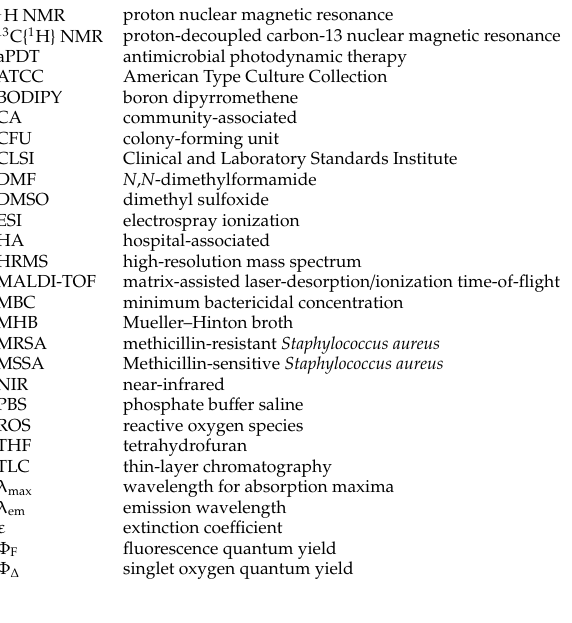
Figure S1: (a) 1 H and (b) 13 C{ 1 H} NMR spectra of 1 in DMSO- d 6 , Figure S2: (a) 1 H and (b) 13 C{ 1 H} NMR spectra of 2 in DMSO- d 6 , Figure S3: 1 H NMR spectrum of 3 in DMSO- d 6 , Figure S4: 1 H NMR spectrum of 4 in DMSO- d 6 , Figure S5: (a) 1 H and (b) 13 C{ 1 H} NMR spectra of 5 in CDCl 3 , Figure S6: (a) 1 H and (b) 13 C{ 1 H} NMR spectra of 8 in CDCl 3 , Figure S7: (a) 1 H and (b) 13 C{ 1 H} NMR spectra of 10 in DMSO- d 6 , Figure S8: (a) 1 H and (b) 13 C{ 1 H} NMR spectra of 12 in CDCl 3 , Figure S9: (a) 1 H and (b) 13 C{ 1 H} NMR spectra of 14 in CDCl 3 , Figure S10: 1 H NMR spectrum of 18 in CDCl 3 , Figure S11: 1 H NMR spectrum of 19 in CDCl 3